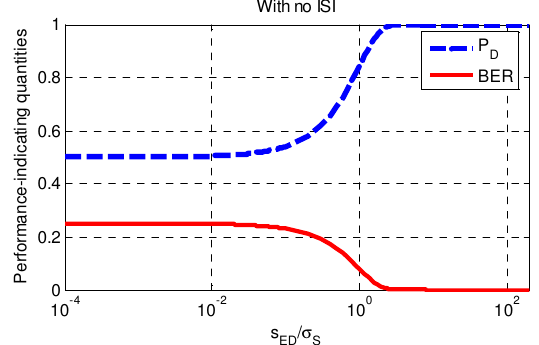
Fig. 2. Detection probability and BER in the absence of ISI